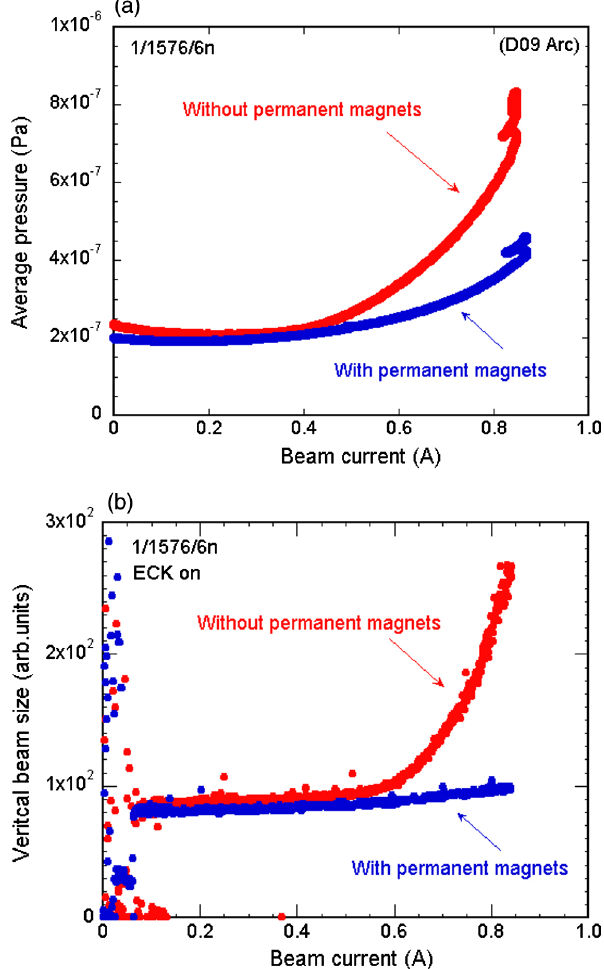
FIG. 10. Behaviors of (a) average pressure in an arc section and (b) vertical beam size versus beam current without and with permanent magnets on Al-alloy bellows chambers for the 1 = 1576 = 6 n bunch fill